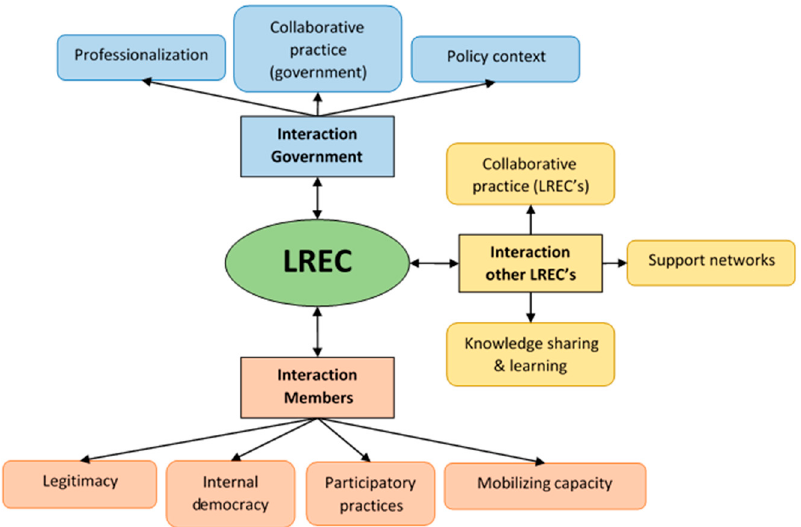
Figure 2. Conceptual framework of local renewable energy cooperative (LREC) interactions and governance dimensions.